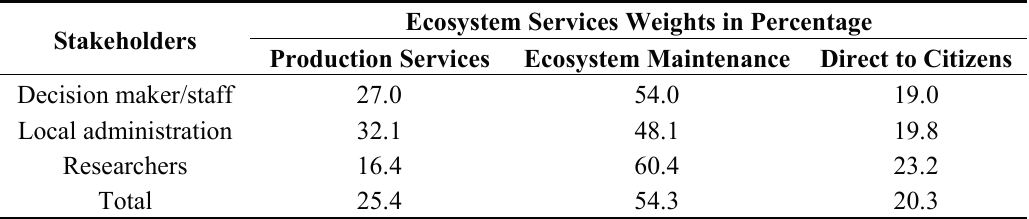
Table 2. Preferences for ecosystem services by functions and group of stakeholders in percentage obtained by AHP method.